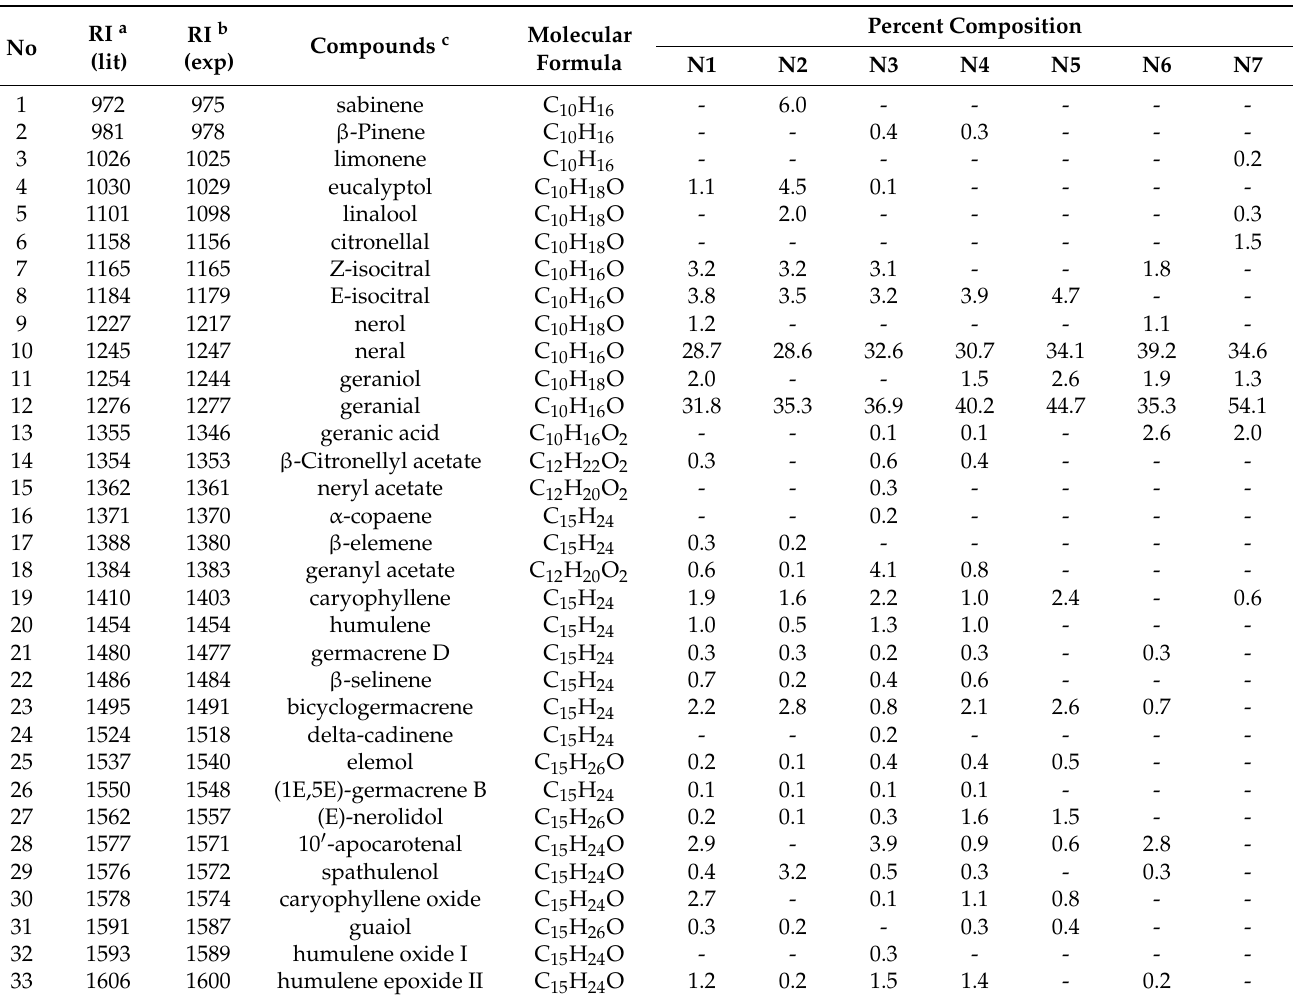
Table 2. Essential oil composition of citral chemotype C. camphora and C. bodinieri